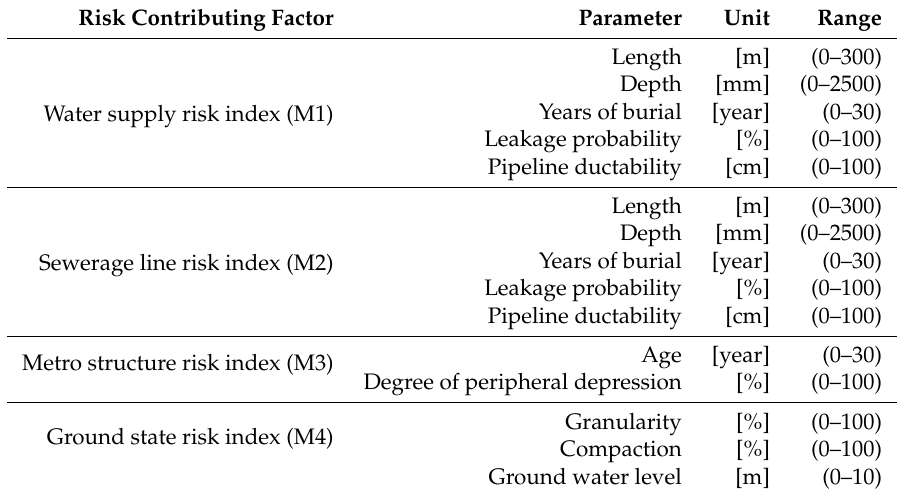
Table 5. Selected parameters range and units for four risk contributing factors